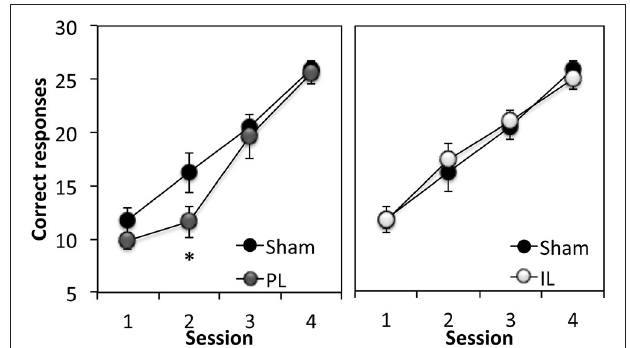
FIGURE 3 | Acquisition of discrete cue conditioning . Mean ± SEM performance of sham-operated controls and prelimbic (PL—left panel) or infralimbic (IL—right panel) lesion groups in discrete cue conditioning, expressed as the number of “correct” responses made out of 30 trials in each session. A “correct” response was defined as responding to the CS within 15 s of its onset. * p < 0.05 compared to sham